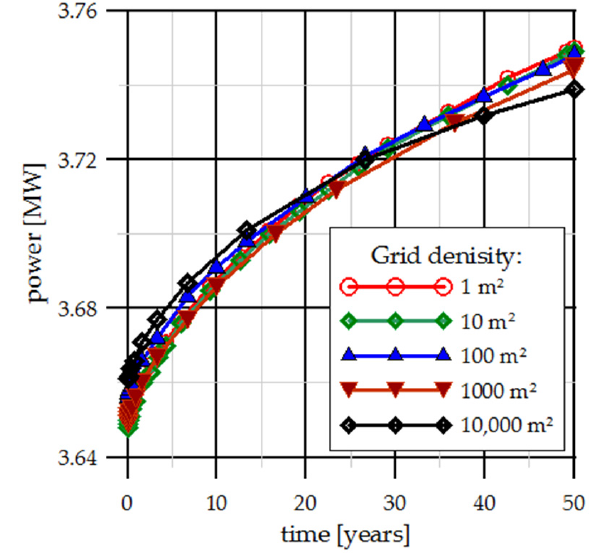
Figure 8. Variation of thermal power vs. time as function of grid density.